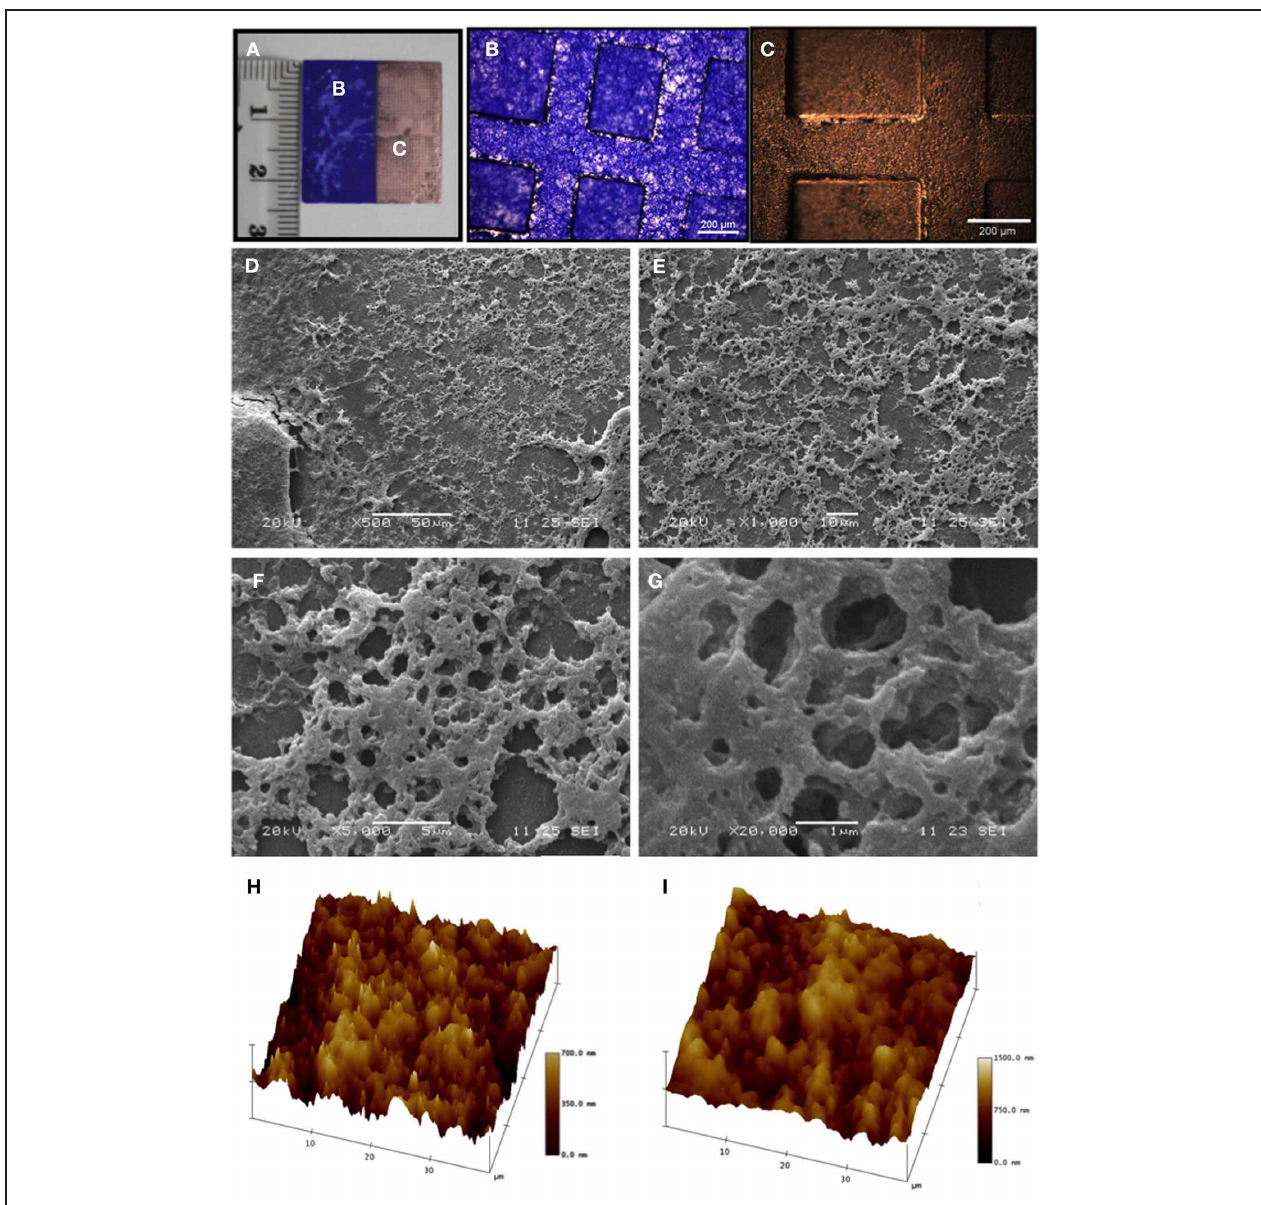
FIGURE 2 | Micro- and nanocharacterization of the neural ECM. (A–C) Before mounting, samples (A) were stained with Coomassie blue (B) and then coated by a thin gold layer (C) . (D-G) Matrix characterization by scanning electron microscopy (SEM). At a lower magnification ( D , 500 × , scale bar 50 μ m), a homogeneous coating of valleys in the patterned substrate may be appreciated. At higher magnifications ( E , 1,000 × , scale bar 10 μ m; F , 5,000 × ,